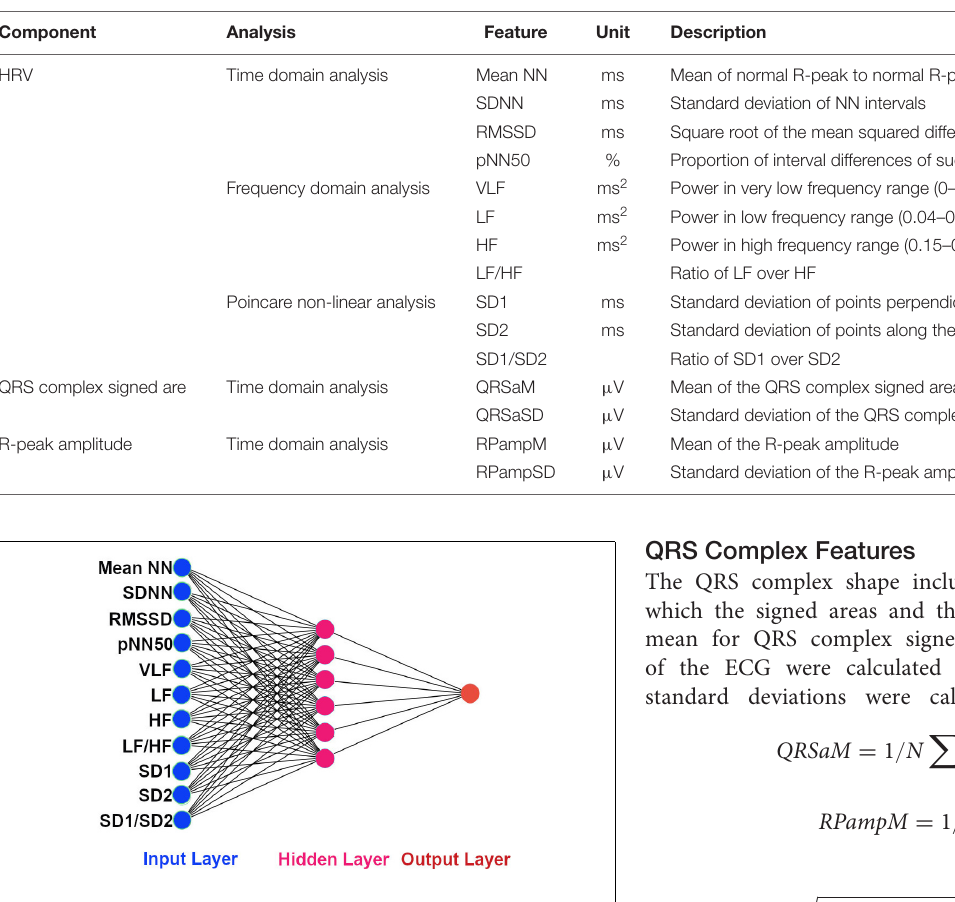
FIGURE 2 | The architecture of our ANN using 11 HRV features. The input features to the ANN. Mean NN: mean normal R-peak to normal R-peak interval, SDNN: standard deviation of NN, RMSSD: square root of mean squared difference of successive NN, pNN50: proportion of interval differences of successive NN intervein greater than 50 ms, VLF: very low frequency, LF: low frequency, HF: high frequency, SD1: standard deviation of points perpendicular to the axis of line of identity, SD2: standard deviation of points along the axis of identity, and the ratio of SD1 and SD2.